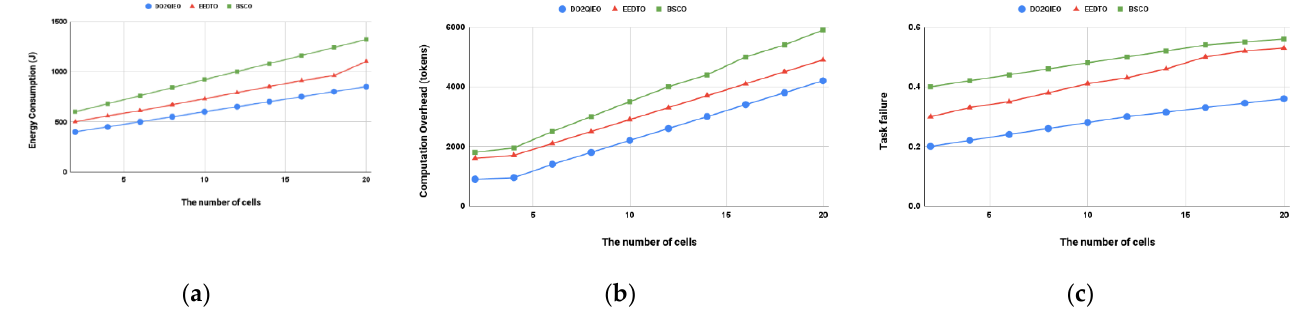
Figure 6. Consumption of energy ( a ), Computation overhead ( b ), and IoT Task failure rate ( c ) for the given number of cells.